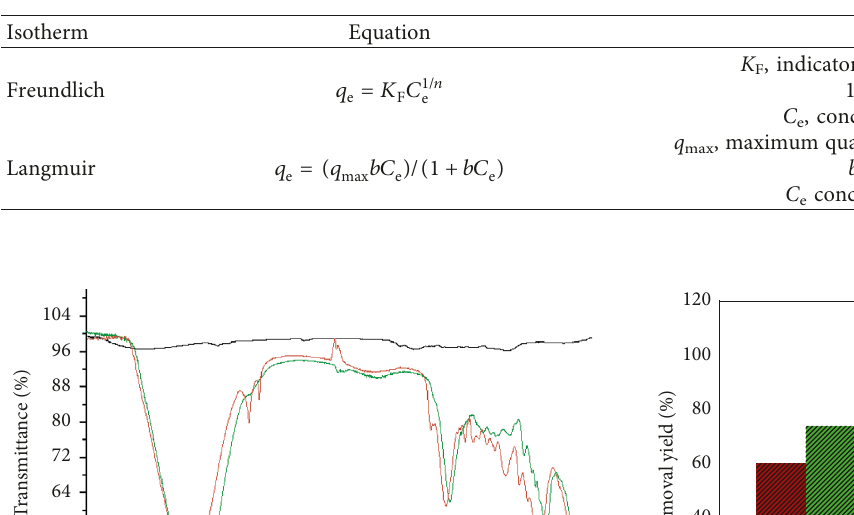
Table 2: Parameters of isotherm models.